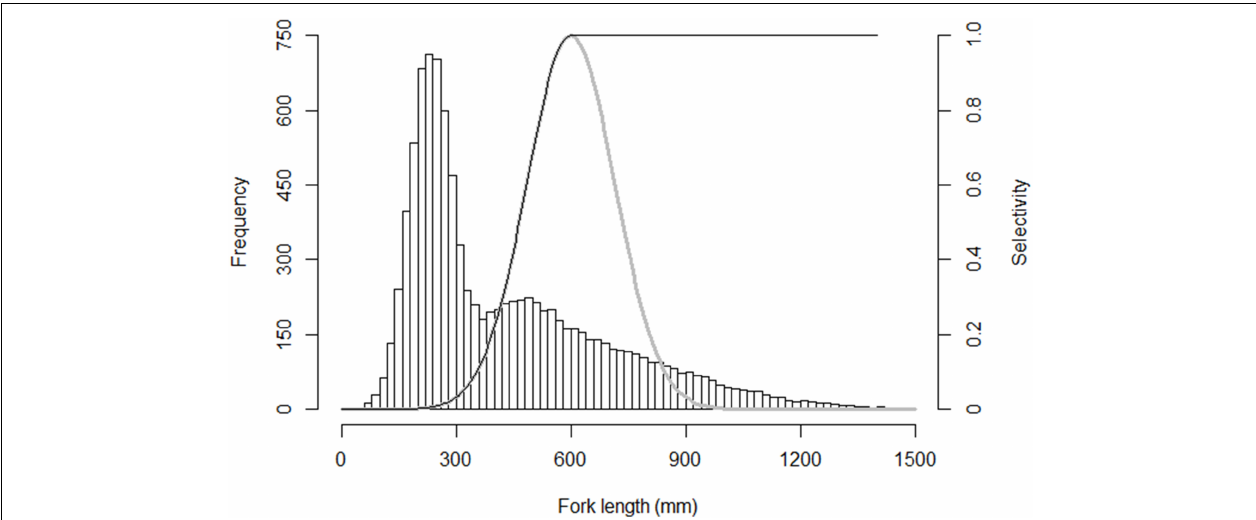
FIGURE 1 | Fork length distribution of Japanese Spanish mackerel populations and size-selectivity curves used to impose selection on Japanese Spanish mackerel life histories. At maximum selectivity, fish of that size are harvested at the rate specified by the parameter H. The bell-shaped size-selectivity curve is for gillnet. The peak of the Gaussian function is at 600 mm. In each case the standard deviation is 1.5% of the mean. Sigmoid trawl selectivity was modeled based on the same probability distribution as for gillnet, maximum selectivity for all fish with lengths larger than that at the peak